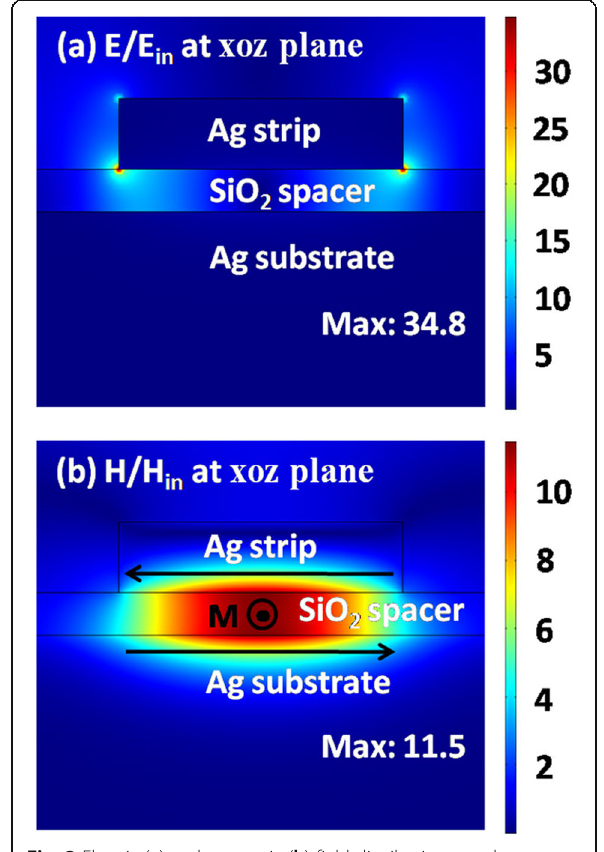
Fig. 3 Electric ( a ) and magnetic ( b ) field distributions on the xoz plane at the magnetic dipole resonance